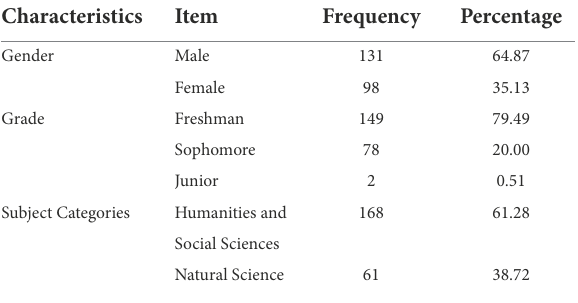
TABLE 1 Demographic background of study participants (N =